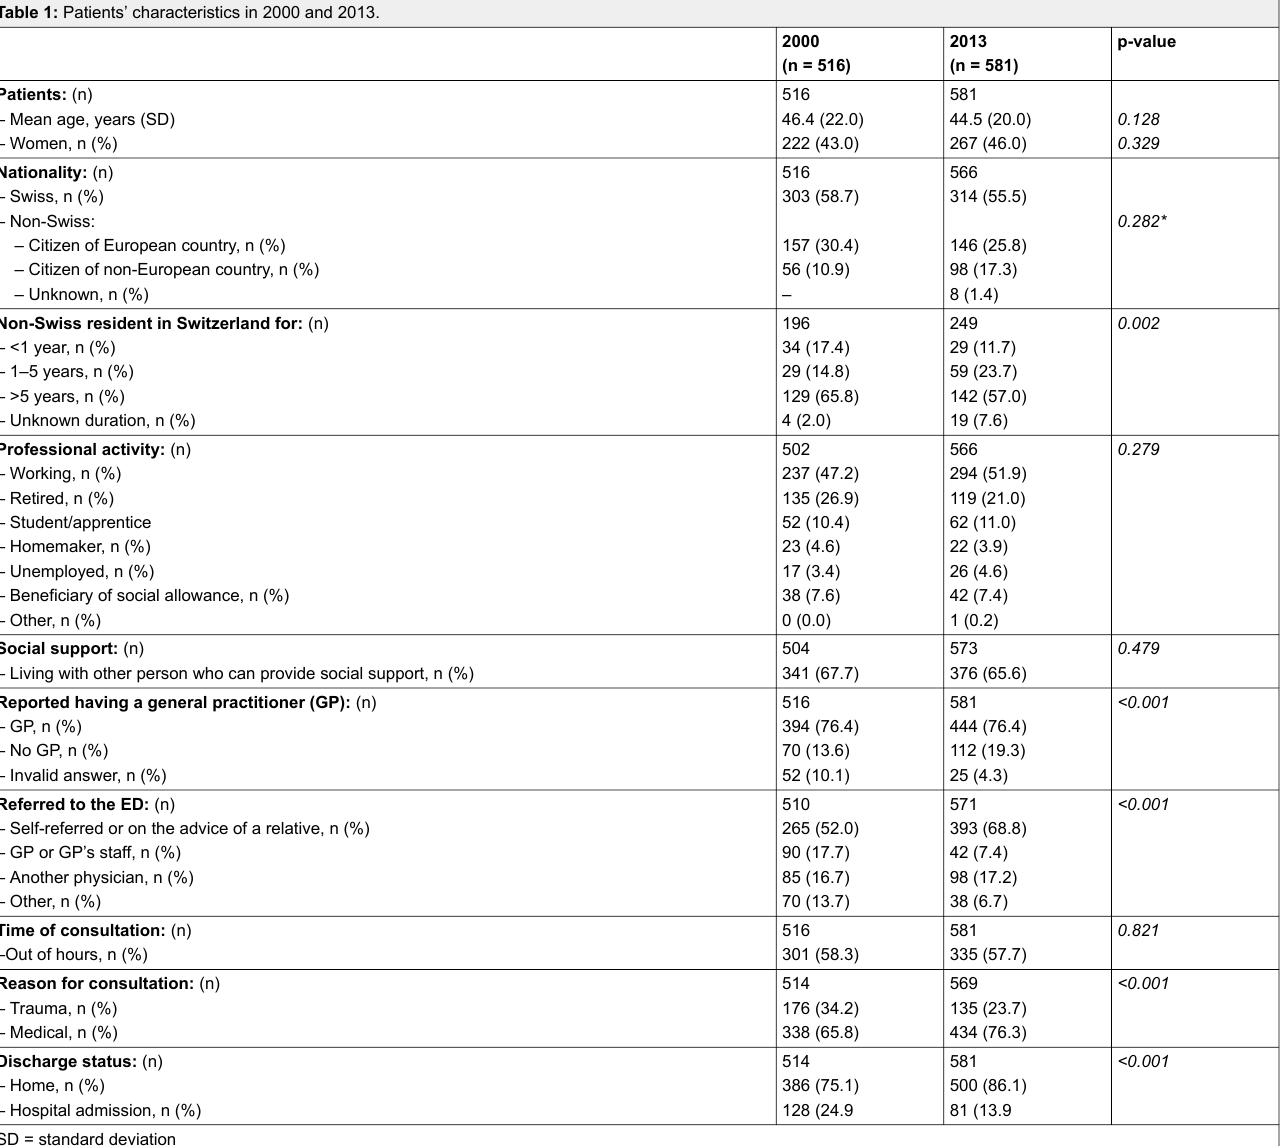
Table 1: Patients’ characteristics in 2000 and